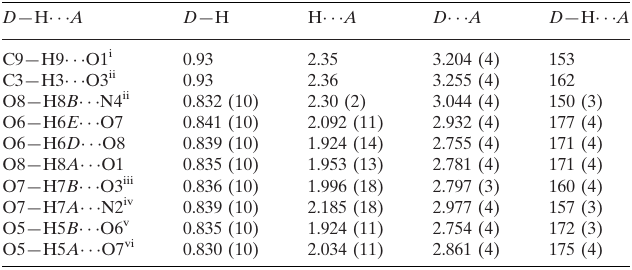
Hydrogen-bond geometry (A˚ , (cid:3)